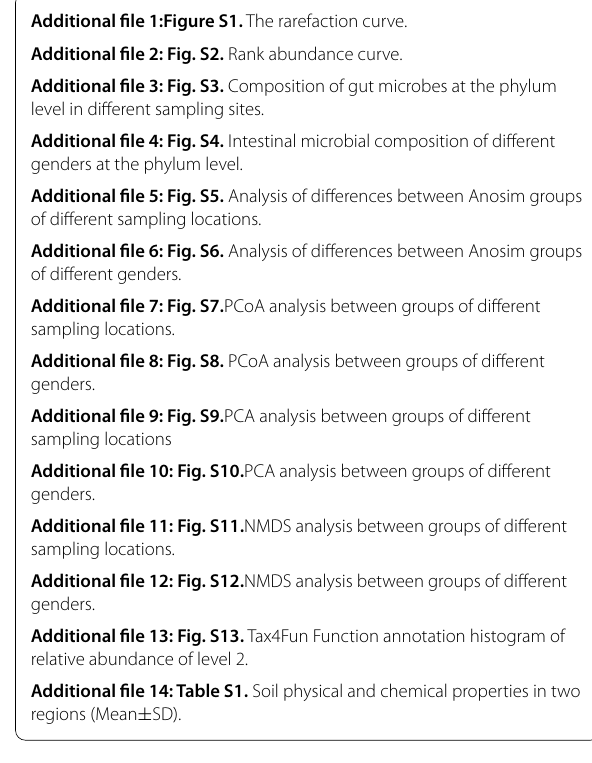
Additional file 1:Figure S1. The rarefaction curve. Additional file 2: Fig. S2. Rank abundance curve.